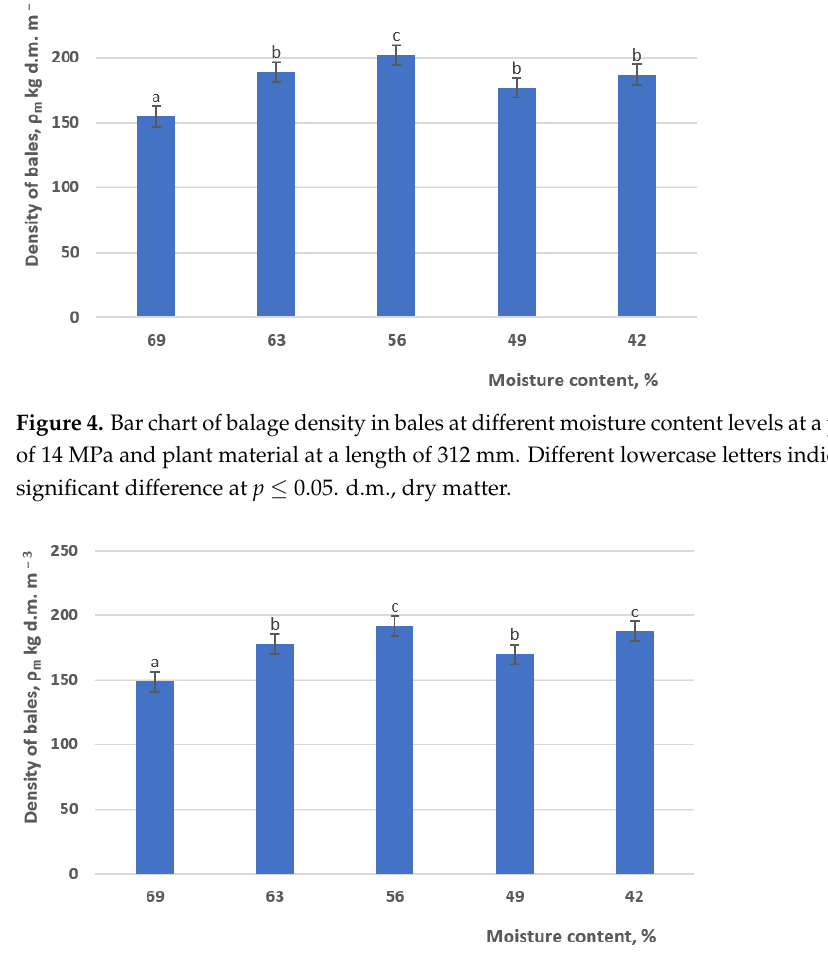
Figure 3. Bar chart of balage density in bales at different moisture content levels at a pressing pres- sure of 18 MPa and plant material at a length of 312 mm. Different lowercase letters indicate a sta- tistically significant difference at p ≤ 0.05. d.m, dry matter.